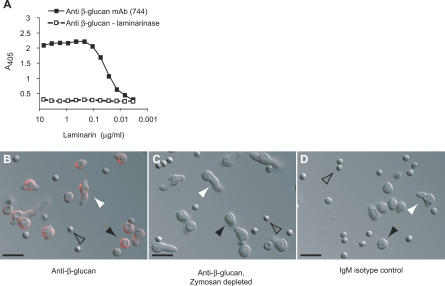
Germinating but Not Resting A. fumigatus Conidia Display β-Glucans on the Cell Surface(A) The mAb 744 detects β-glucans. Decreasing laminarin concentrations were coated onto ELISA plates in the presence or absence of laminarinase. 10 μg/ml mAb 744 was added to the wells and detected using an alkaline phosphatase conjugated anti-mouse IgM.(B–D) A. fumigatus conidia were incubated in RPMI for 7 h, stained with mAb 744 (B), mAb 744 depleted by zymosan (C), or IgM control antibody (D), followed by Alexa Fluor 594-anti-mouse IgM, and examined by confocal microscopy. Representative DIC/epifluorescence confocal images of resting conidia (open arrowheads), swollen conidia (black arrowheads), and early germlings (white arrowheads) are shown in overlay. Scale bar = 10 μm.